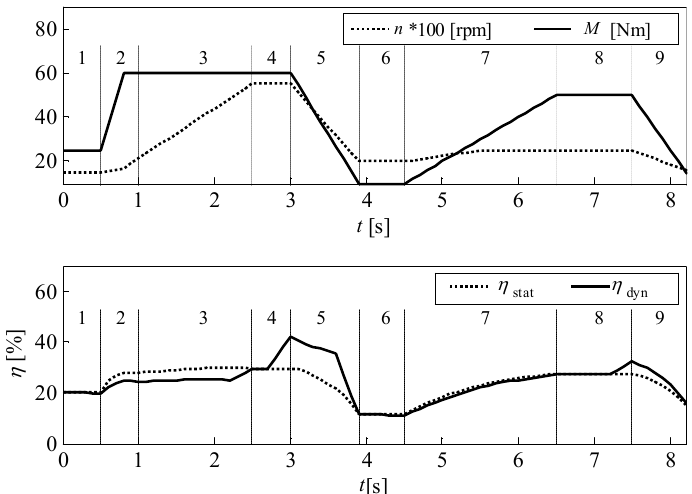
Figure 14. Engine efficiency in different working states based on the ANN characteristic ( η dyn ) and Figure 14. Engine e ffi ciency in di ff erent working states based on the ANN characteristic ( η dyn ) and static characteristic ( η stat ). static characteristic ( η stat